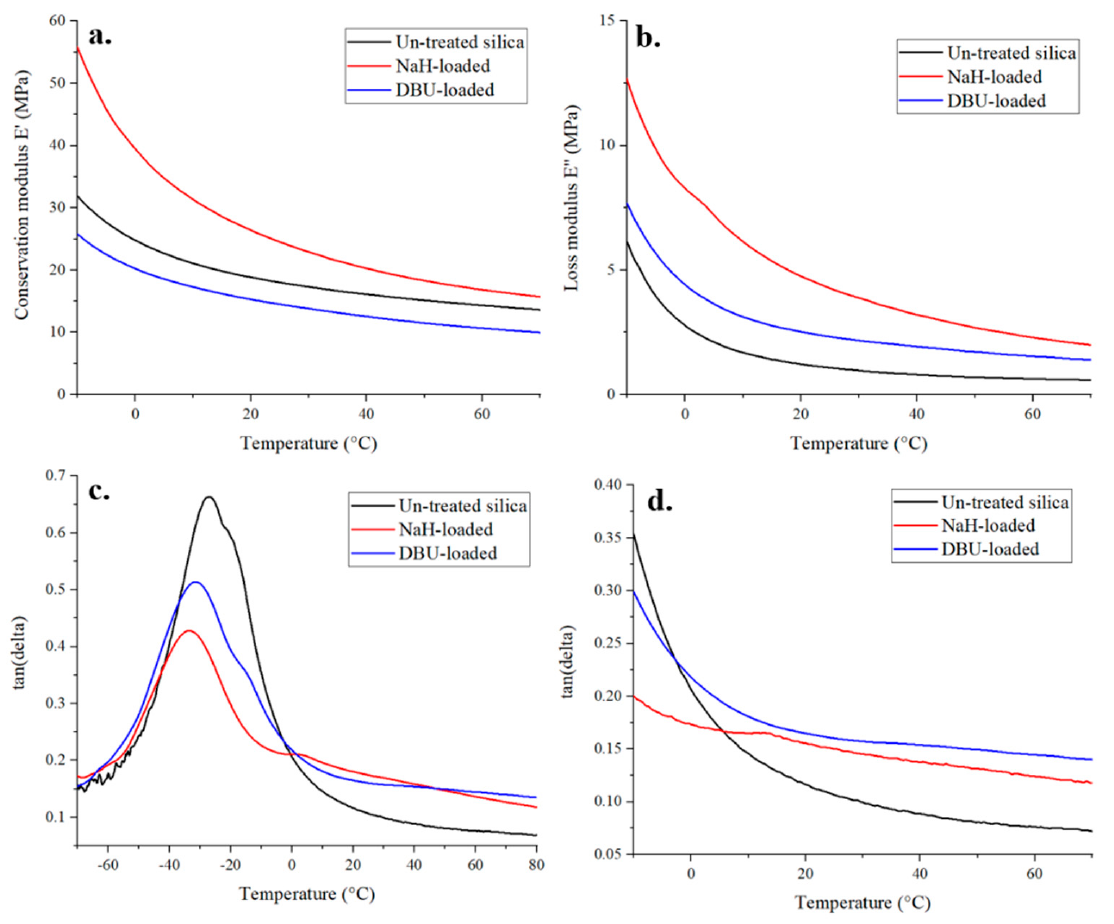
(cid:48) ( a ), E” ( b ) and tan( δ ) ( c , d